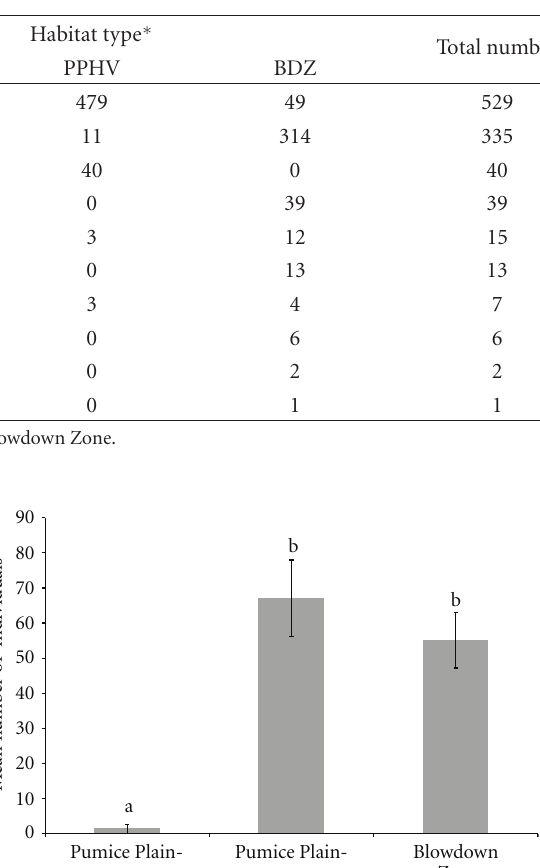
Table 2: List of ant species and numbers collected in each habitat type at Mount St. Helens National Volcanic Monument between 22 and 25 July 2008.